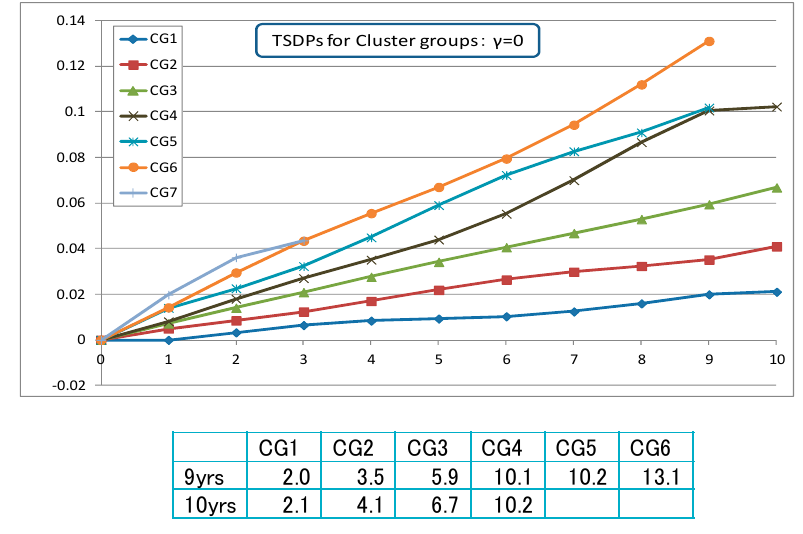
Figure 17. TSDPs of CG1–CG4.